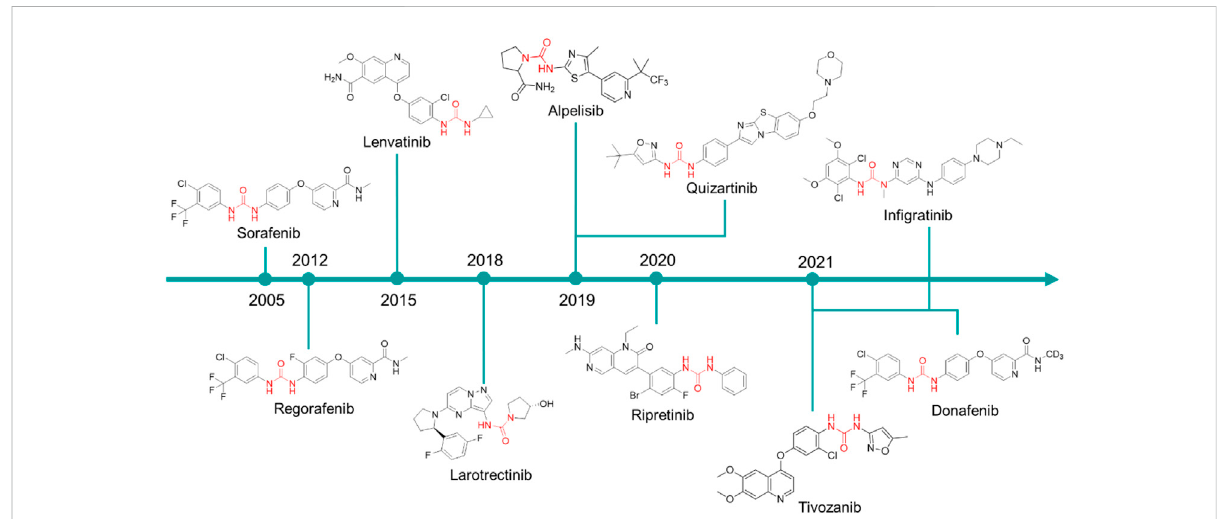
FIGURE 7 Chemical structure of the kinase inhibitors based on aryl-urea moiety approved for clinical use in humans from 2005 to 2021.